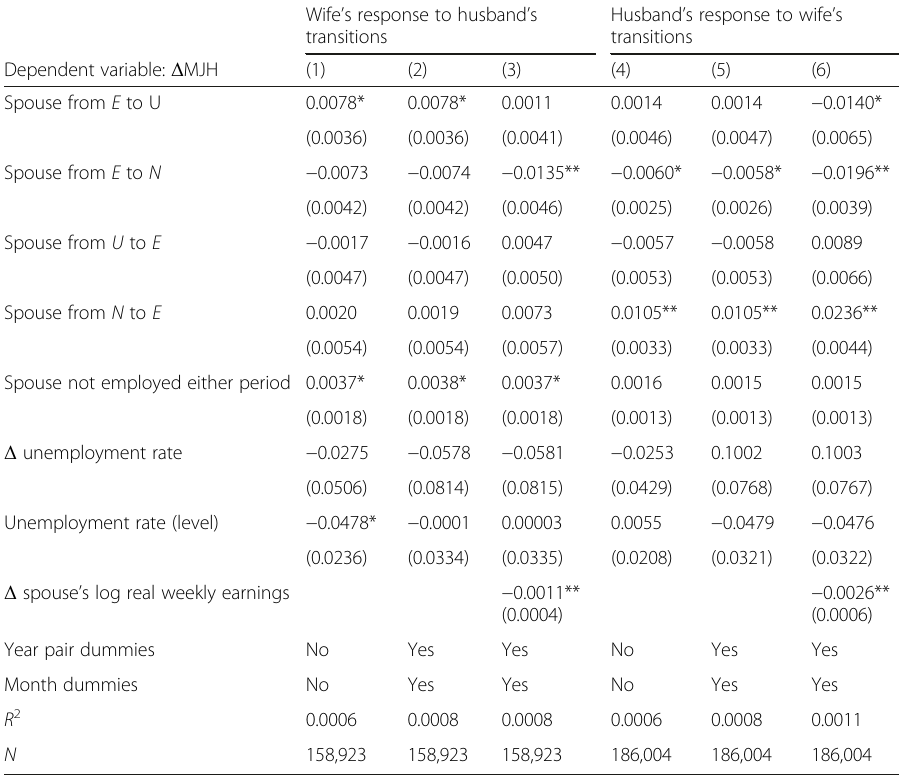
Table 8 Panel analysis of married workers ’ MJH response to spouses ’ labor market